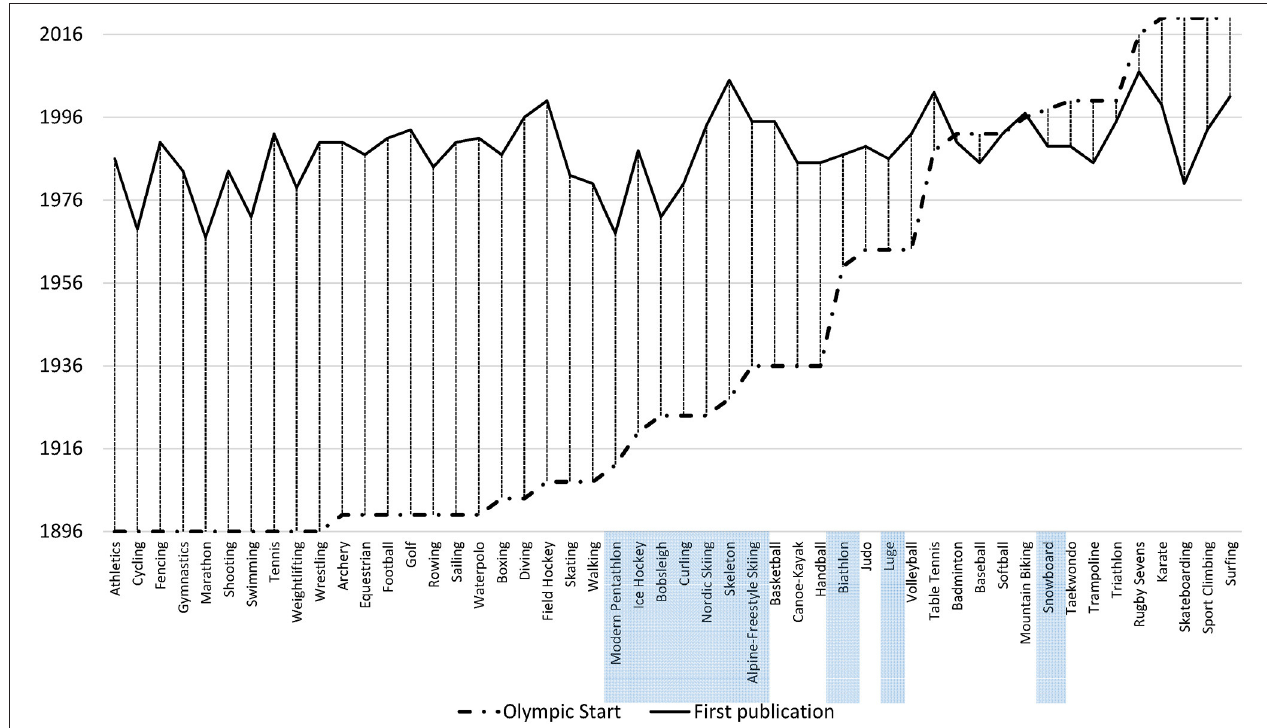
FIGURE 1 | Dates of the Olympic debut and of first publication across all summer and winter Olympic sports. Winter sports are